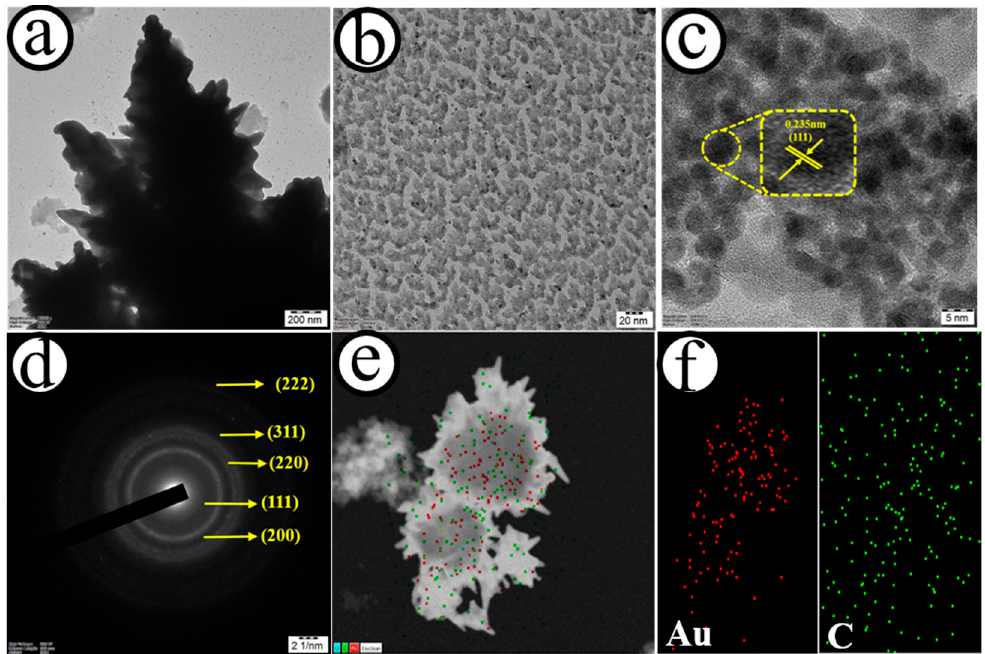
Figure 2. TEM ( a , b ), HRTEM ( c ), SAED pattern ( d ) and elemental mapping ( e , f ) of